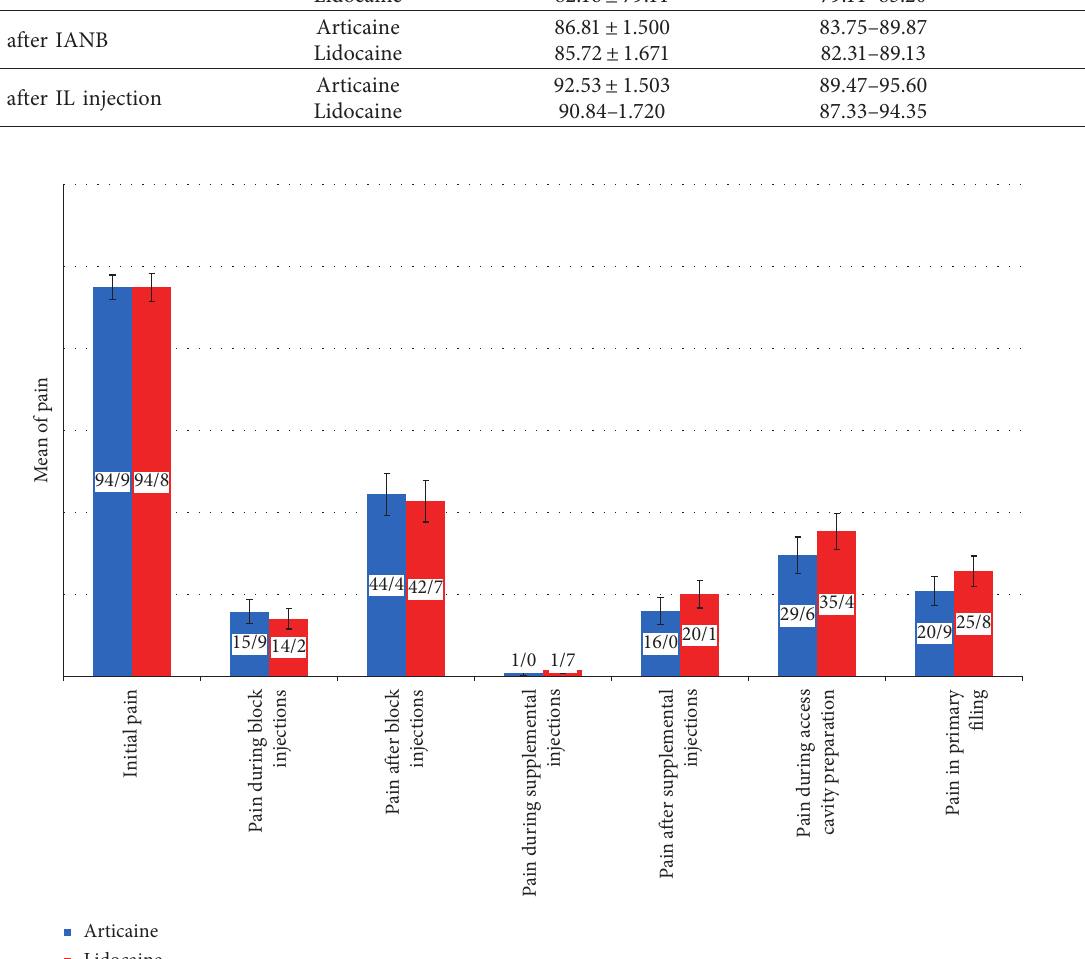
Figure 2: Summary of